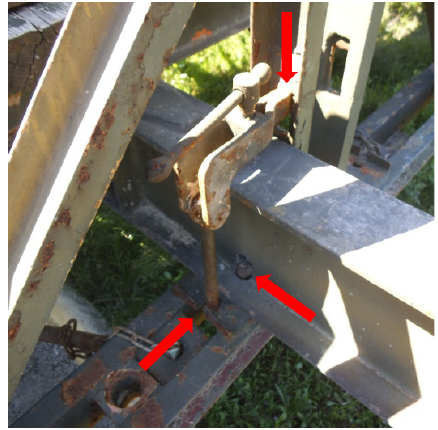
Figure 23. Panel—cross-beam